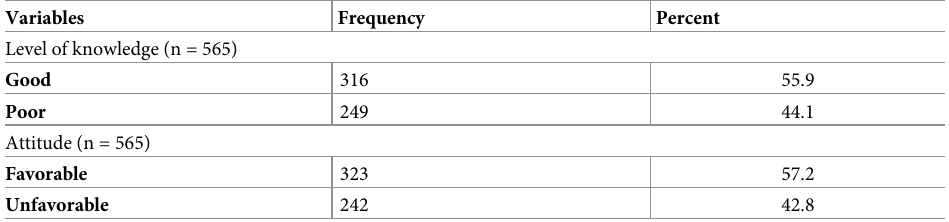
Table 3 showed that the odds of good knowledge regarding refractive error among study participants who had the previous history of spectacle were two times greater than the odds of good knowledge for those subjects who didn’t use spectacle [AOR = 2.13 (95% CI: 1.32, 3.43)]. In addition to this, the odds of good knowledge regarding refractive error among study partici- pants with the previous history of eye examination were 1.67 times larger than the odds of good knowledge for those subjects with no history of eye examination [AOR = 1.67 (95% CI: 1.19, 2.34)]. The odds of good knowledge regarding refractive error among study participants who had previous training on eye health were two times greater than the odds of good knowl- edge for study subjects with no history of training on eye health [AOR = 1.94 (95% CI; 1.09, 3.43)]. The odds of good knowledge regarding refractive error among subjects with 11–20 Table 2. Proportion of the level of knowledge and attitude towards refractive error among study participants in Gondar city, Northwest Ethiopia, 2017. Variables Frequency Percent Level of knowledge (n = 565)